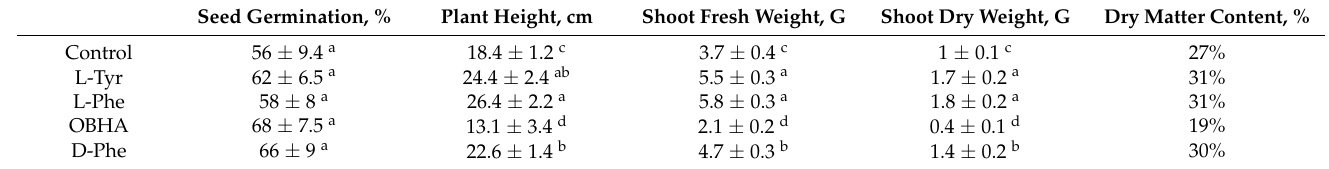
Table 1. Effect of different substances (substrates and potential inhibitors) on growth processes of wheat plants. Seed Germination, % Plant Height, cm Shoot Fresh Weight, G Shoot Dry Weight, G Dry Matter Content, % Control